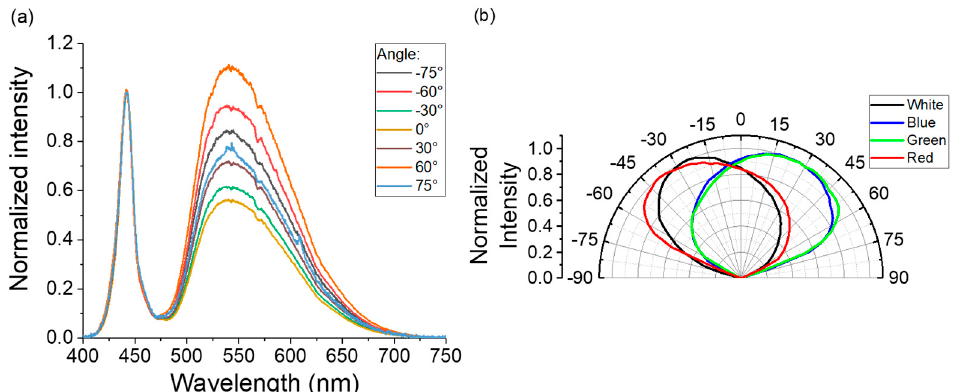
Figure 4. Example of curves obtained using the setup in Figure 3. ( a ) Normalized spectra of a pristine white LED at different angles. ( b ) Normalized intensity radiation pattern for a pristine sample. These results were obtained for the sample NP1.